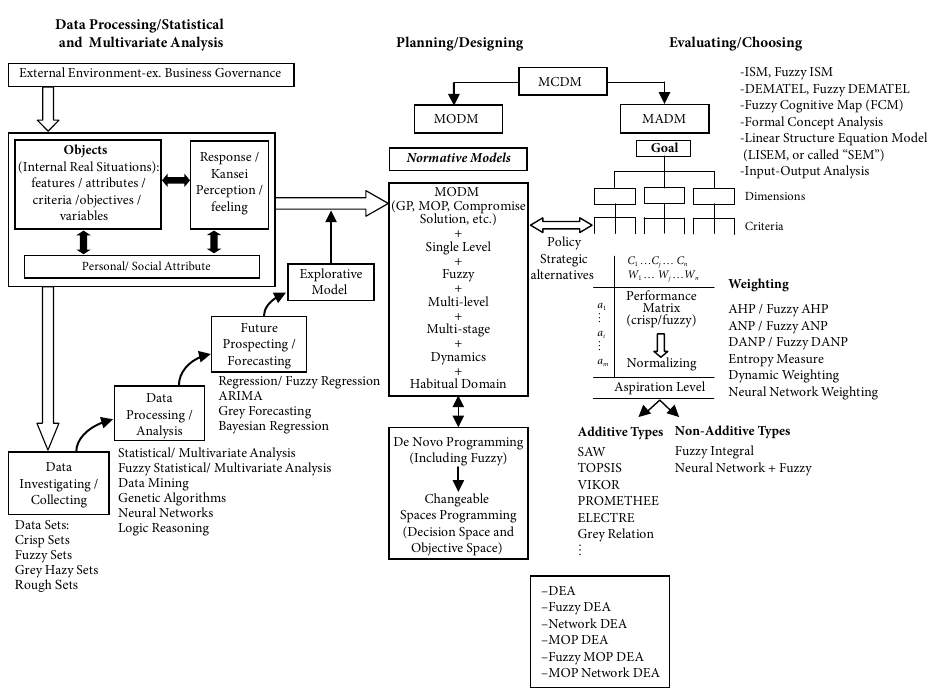
Fig. 1. Basic concepts on overview of social science research with MCDM (Liou, Tzeng